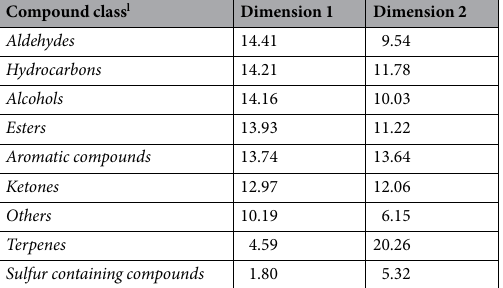
Table 3. Compound classes and their relative contribution to MFA dimensions for the GC-MS analysis. Each dimension of a multivariate analysis can be described by the variables that are used to construct the factorial axes. l Compound classes are sorted according to their relative contributions to dimension 1.